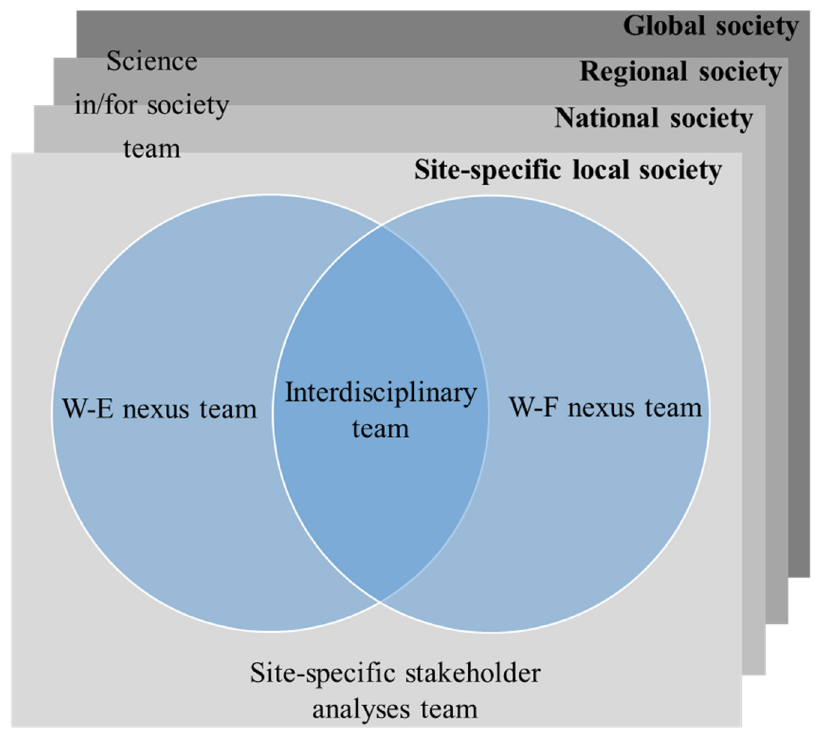
Figure 2. The structure of RIHN WEFN